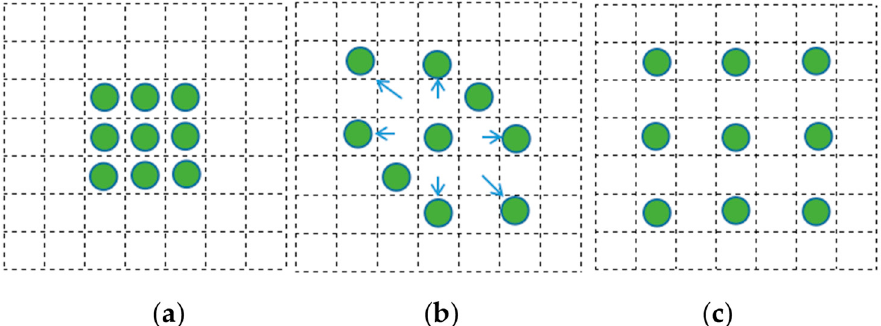
Figure 11. Various convolution receptive fields: ( a ) receptive field of common convolution; ( b ) re-